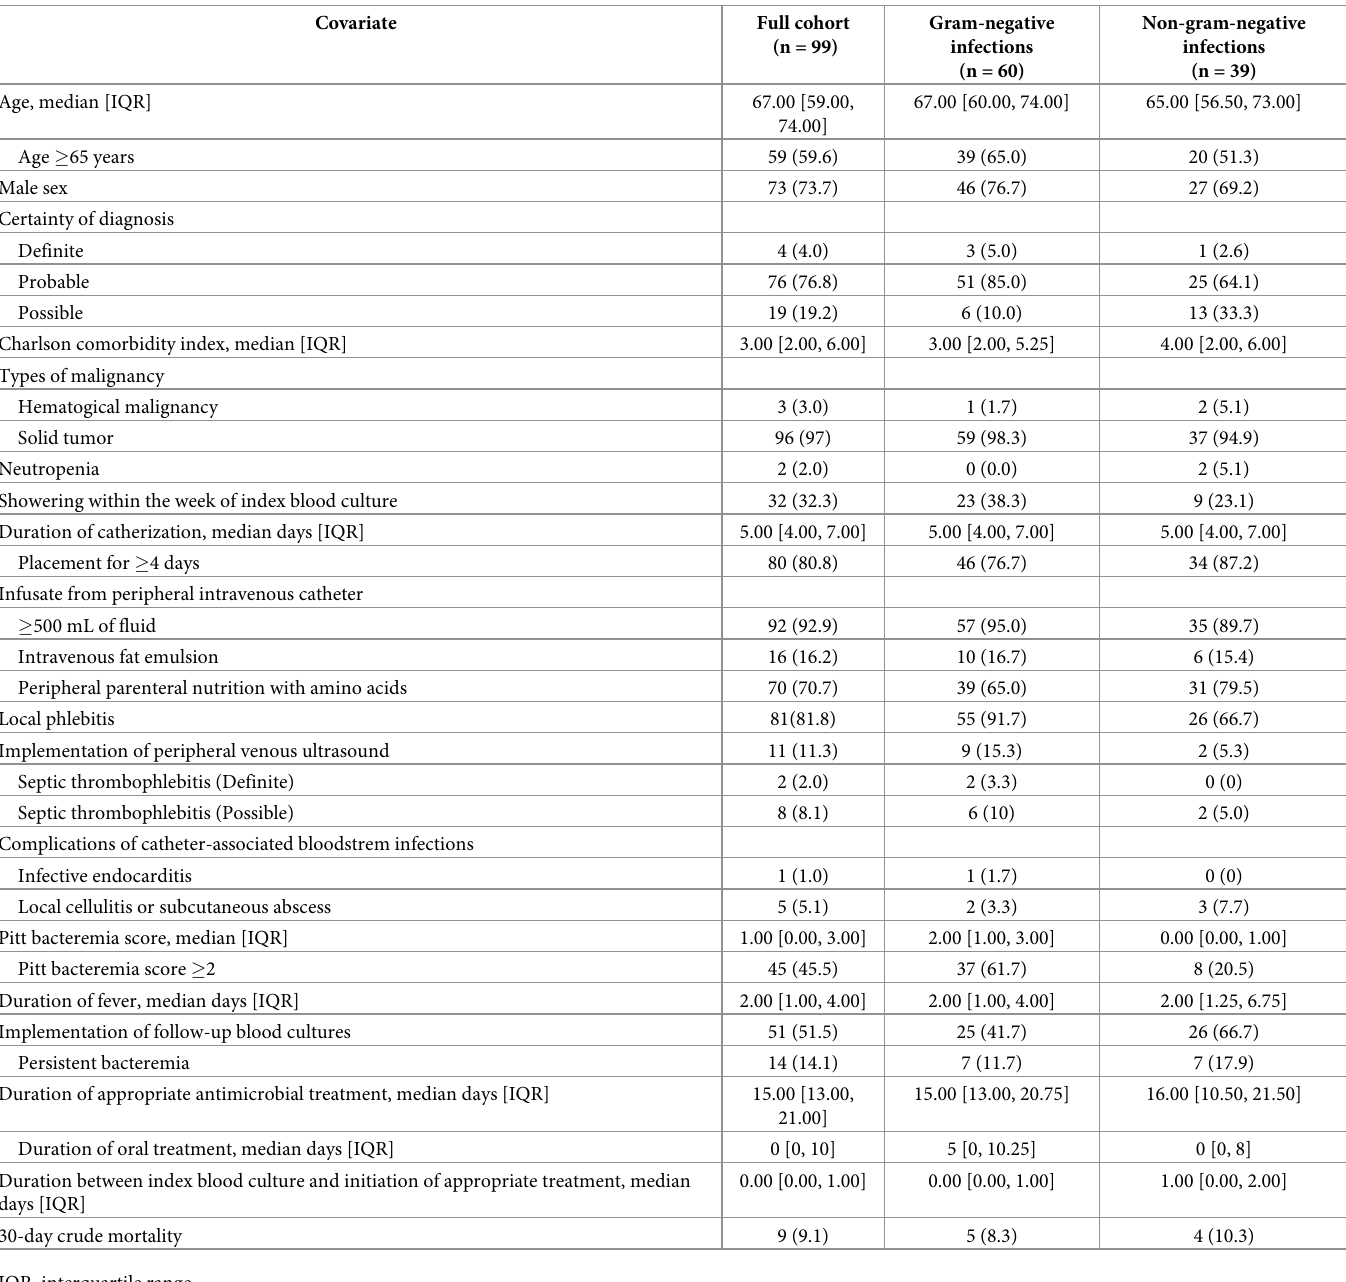
Table 2. Clinical characteristics of the patients with peripheral intravenous catheter-associated bloodstream infections.